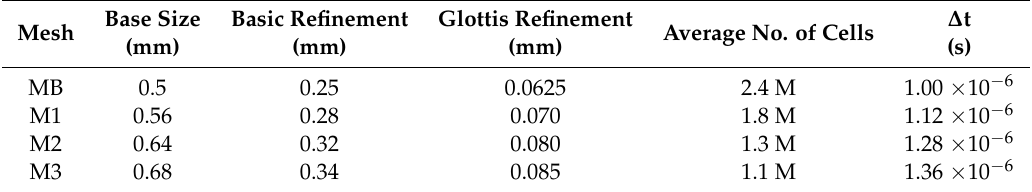
Table 2. Summary of the meshes used for the grid resolution reduction study and their properties. The basic and glottis refinement areas are represented in Figure